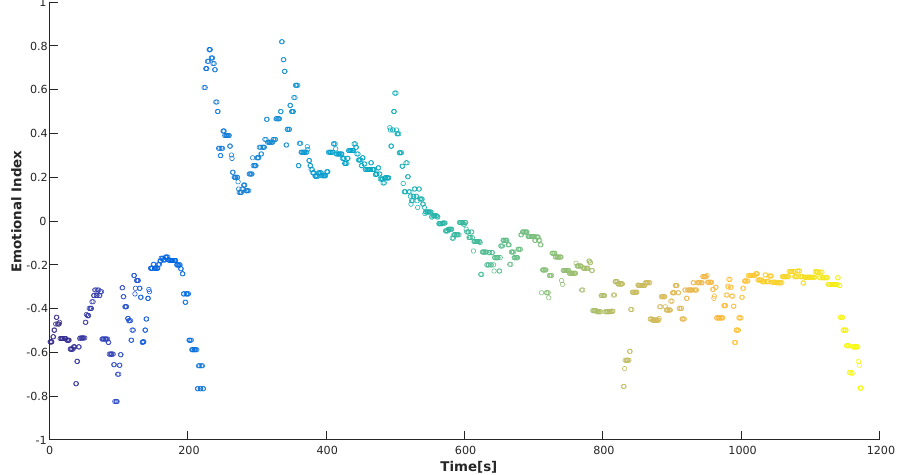
Figure 13. The emotional index graph: Time is on the x -axis and the emotional index in terms of emotion experienced during the execution of rehabilitation exercise is on the y -axis.